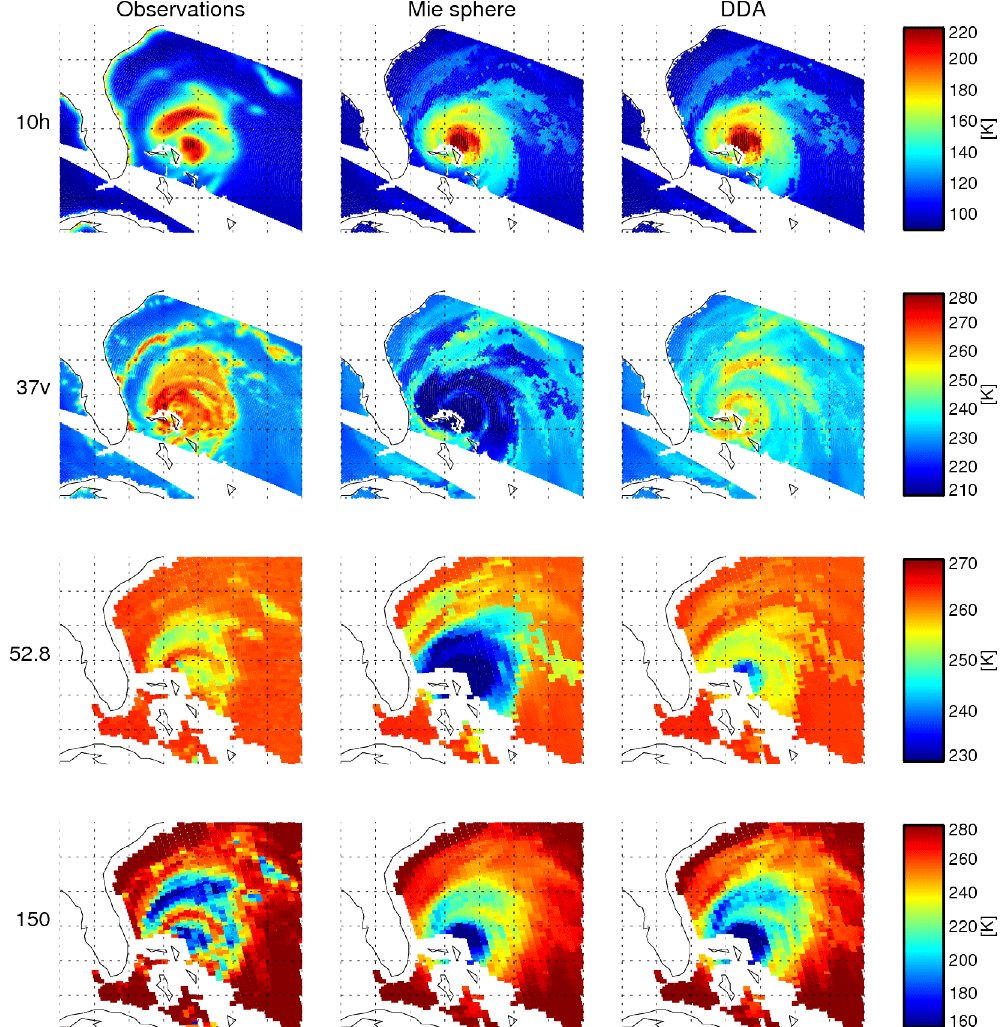
Figure 1. Observed and simulated over-ocean brightness temperatures on 25 August 2011 in the region of Hurricane Irene. Simulations are generated from ECMWF forecasts at T1279 horizontal resolution with snow hydrometeors represented either by Mie spheres or by DDA sector snowflakes. Channels at 10GHz (h = horizontal polarisation) and 37GHz (v = vertical polarisation) come from an overpass of TMI at 21:18UTC. Channels at 52.8GHz and 150GHz (both h polarisation) come from an SSMIS overpass at 22:12UTC. The domain runs from 84 ◦ W to 70 ◦ W and from 22 ◦ N to 34 ◦ N; grid spacing is 2 ◦ . Land-contaminated 10GHz observations on the Florida coast are not used in quantitative